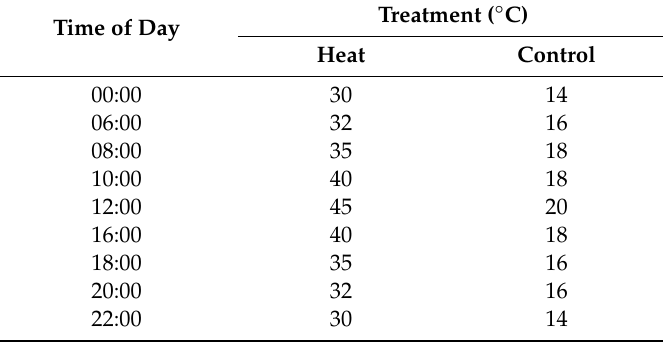
Table 2. Temperature regime for 10 quinoa genotypes exposed to high temperature (heat treatment) and control treatment for a four-day simulated heat wave in growth chambers. Treatment ( ◦ Time of Day